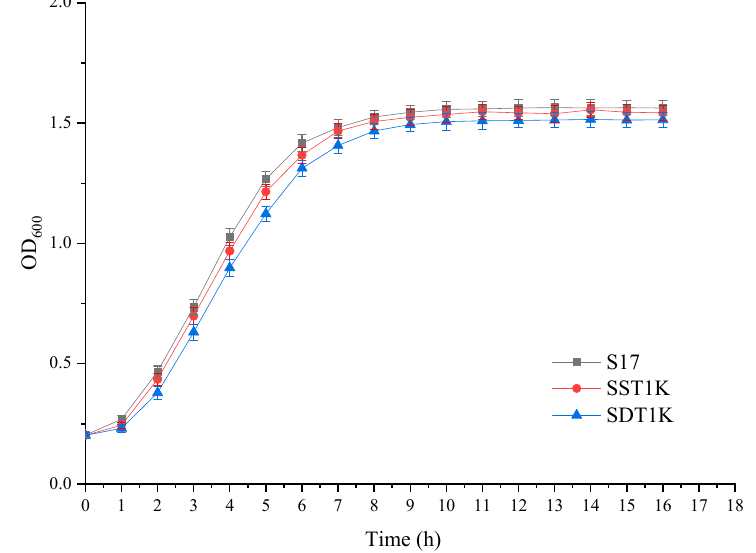
Figure 3. Growth curves of GAT1 deletion mutants and the parental strain S17. Growth curves were plotted using a Bioscreen Automated Growth Curves analysis system. The yeast cells were cultured at 30 °C in YEPD medium, and the optical density (OD 600 ) of the fermentation broth was detected at different times. Data are the average of three independent experiments. Values are means and standard errors.